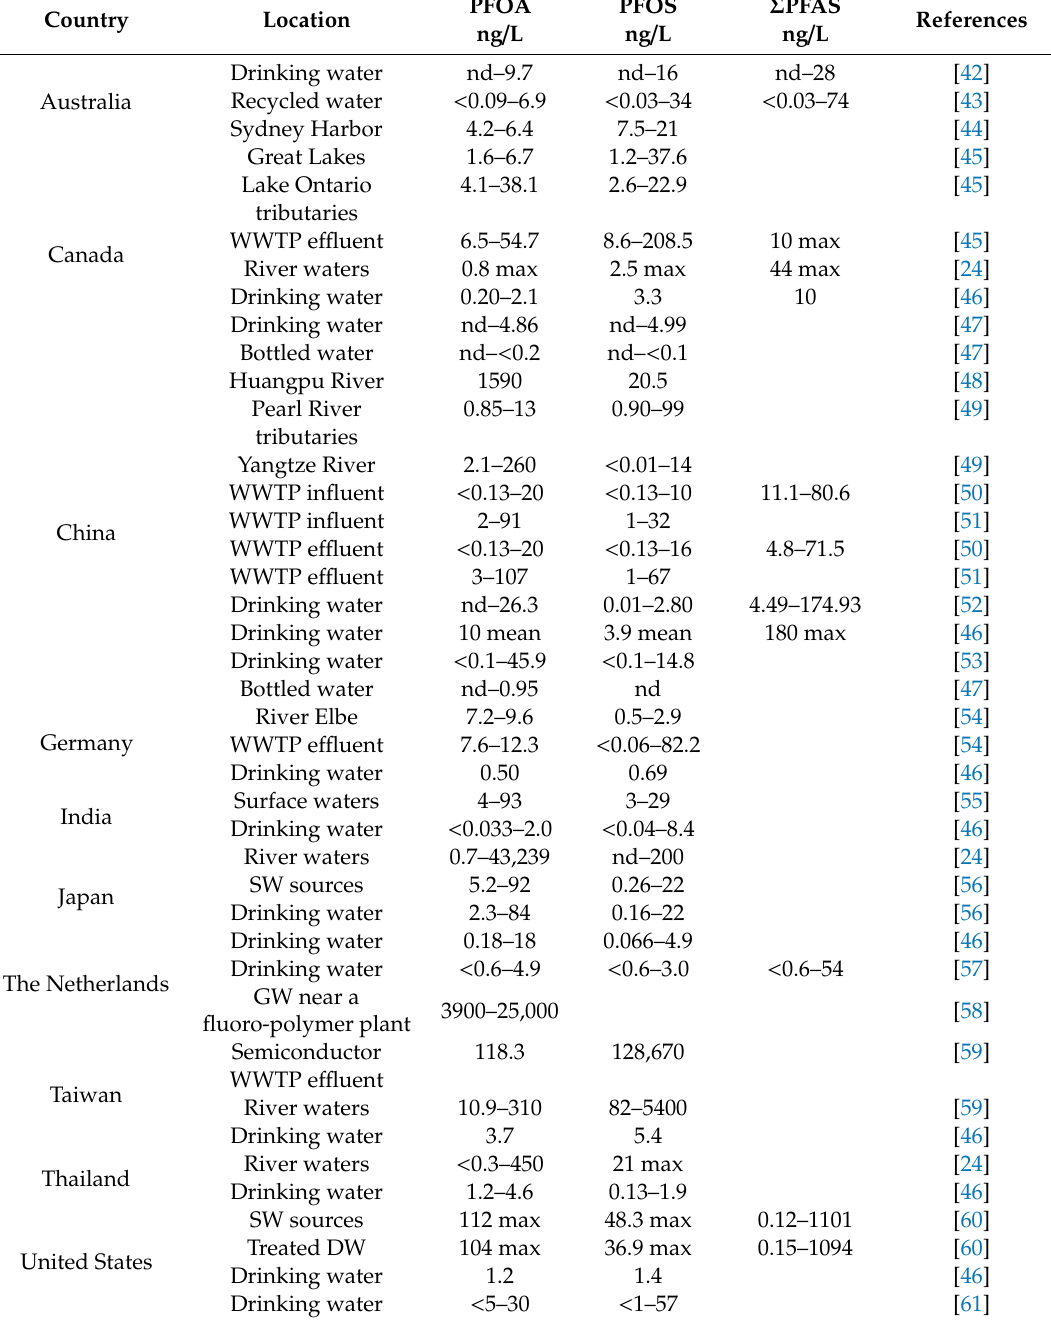
Table 2. Concentrations of perfluorooctanoic acid (PFOA) and perfluorooctane sulfonic acid (PFOS) reported in selected